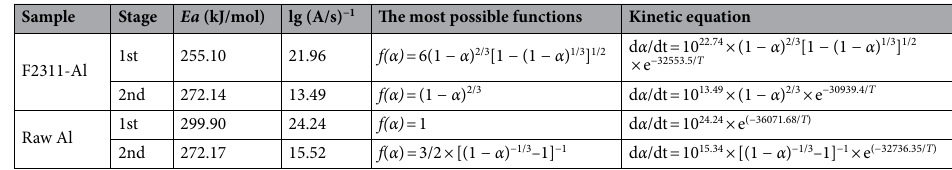
Table 2. Kinetic parameters of exothermic reaction of F2311@Al and ordinary Al.